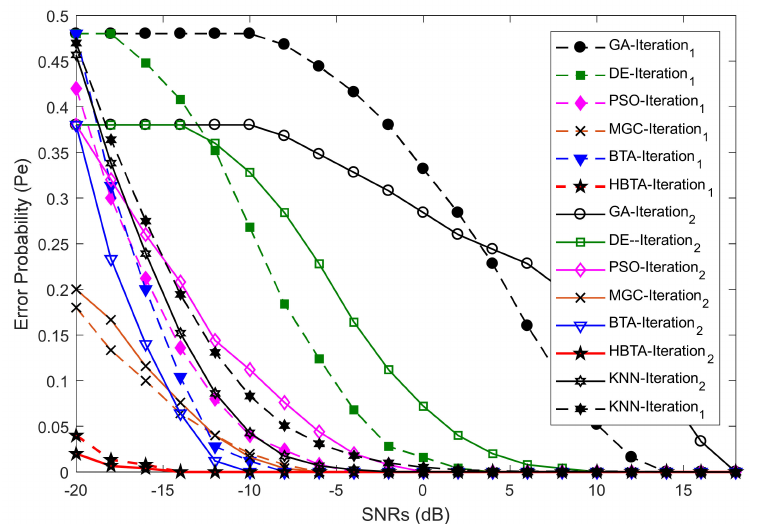
Figure 14. Error probability vs. SNRs in the presence of AN-ANC users with sensing iterations 1 (60) and iterations 2